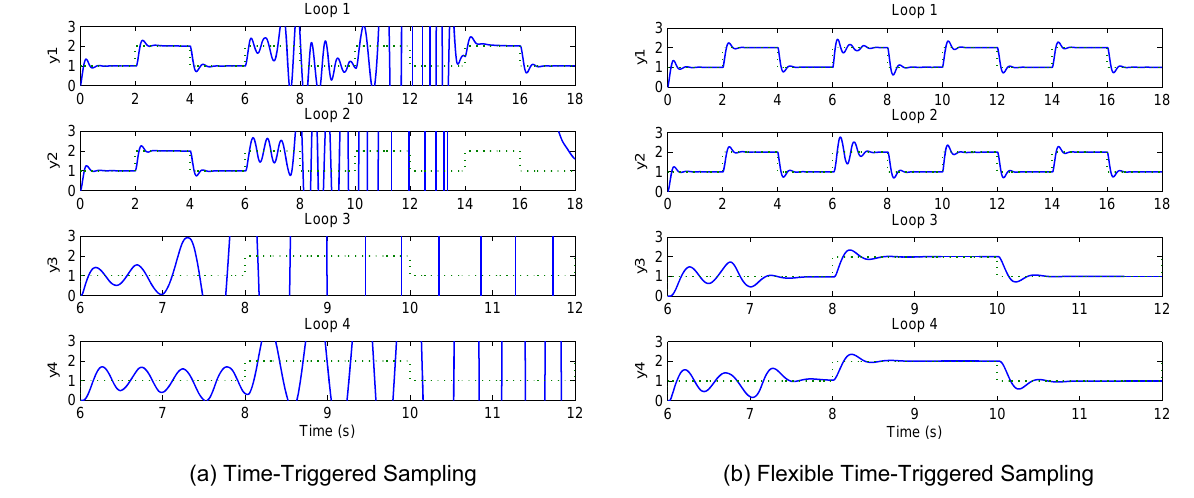
Figure 4. System output under system